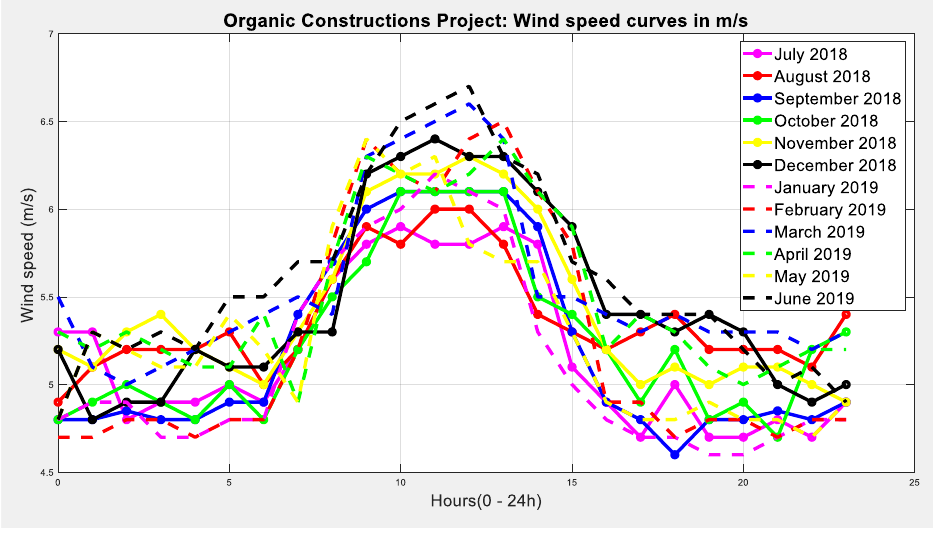
Figure 15. Wind speed profile (July 2018–June 2019).